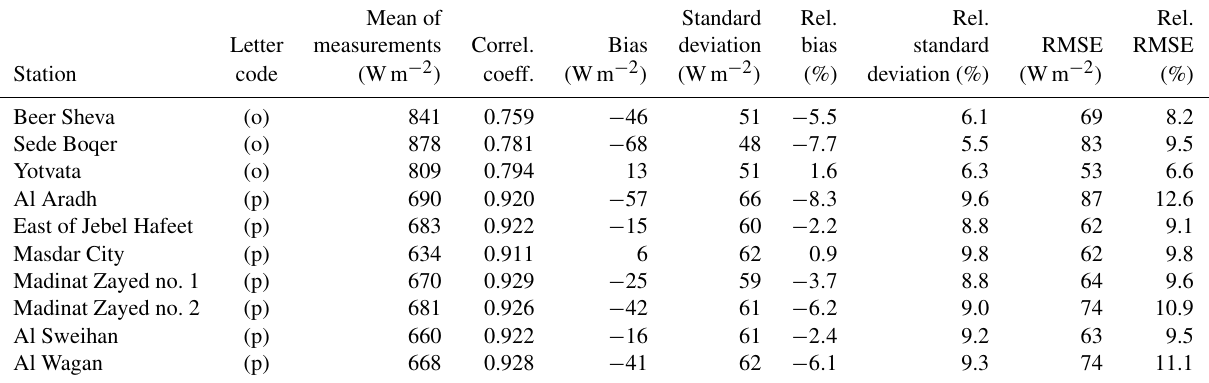
Table B5. Results from previous works at summarization 10min. Means of the measurements, correlation coefficients, bias, standard devia- tions, RMSE, and their values relative to the mean of the measurements for B N